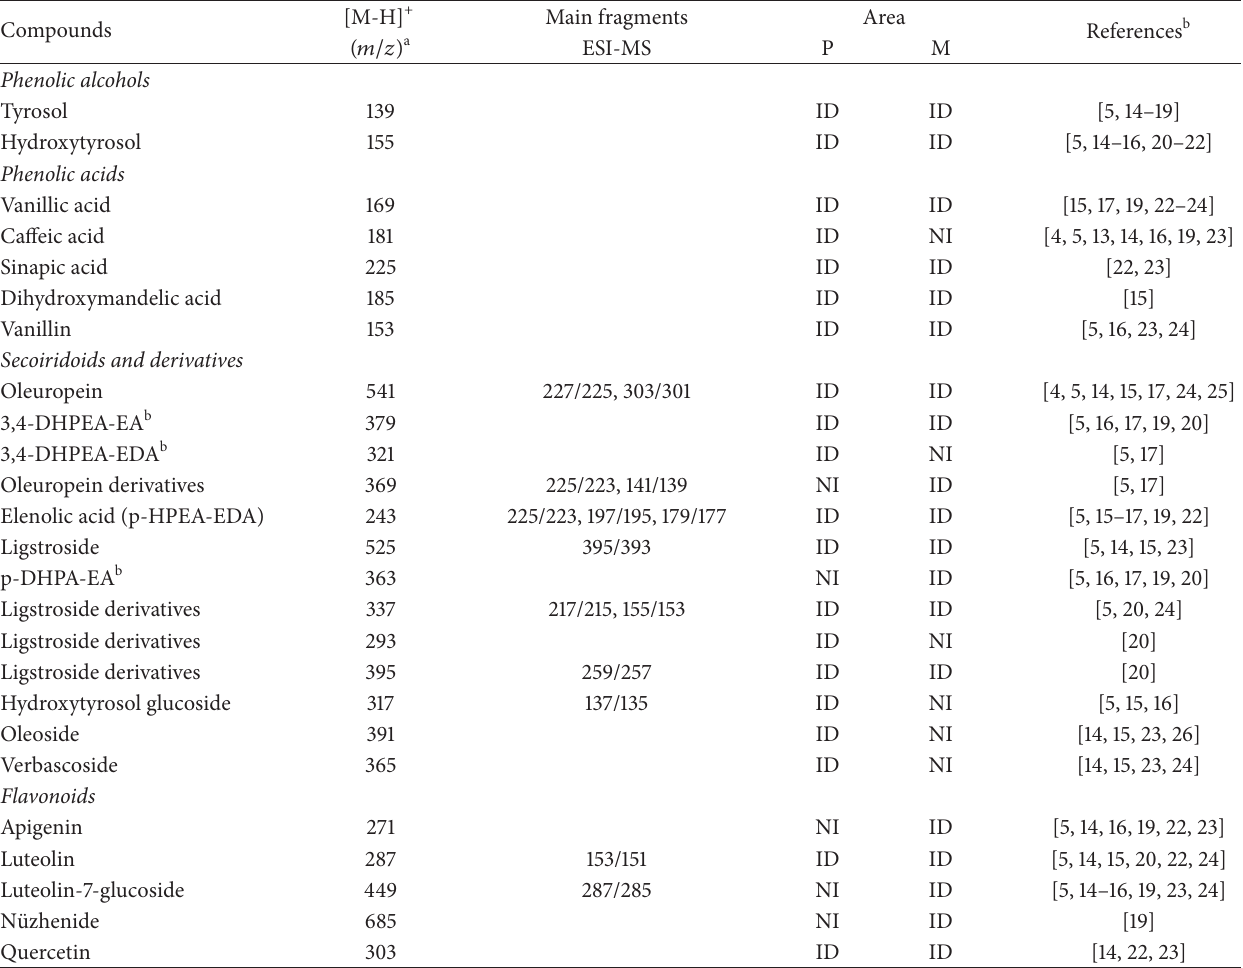
Table 2: Major phenolic compounds identified in